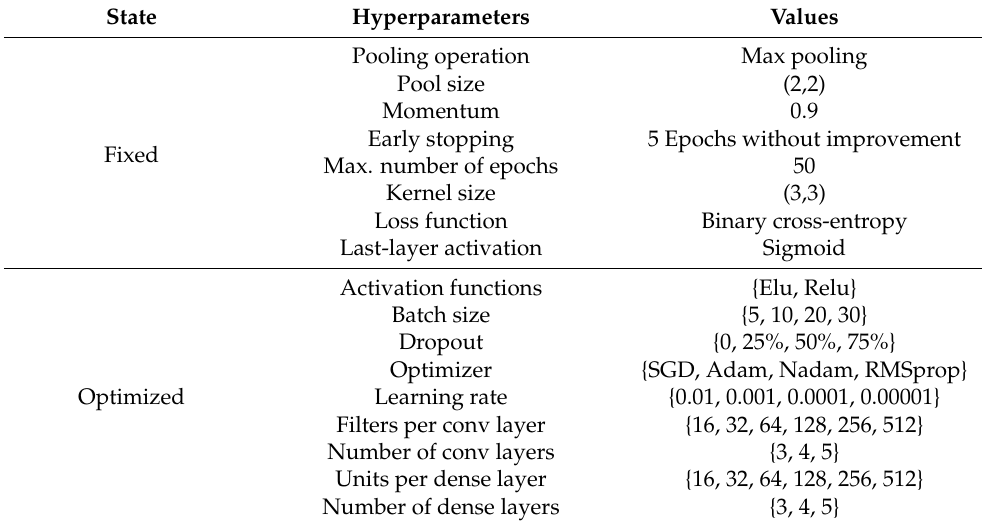
Table 1. T Overview of hyperparameter space used in the optimization of the custom convnet